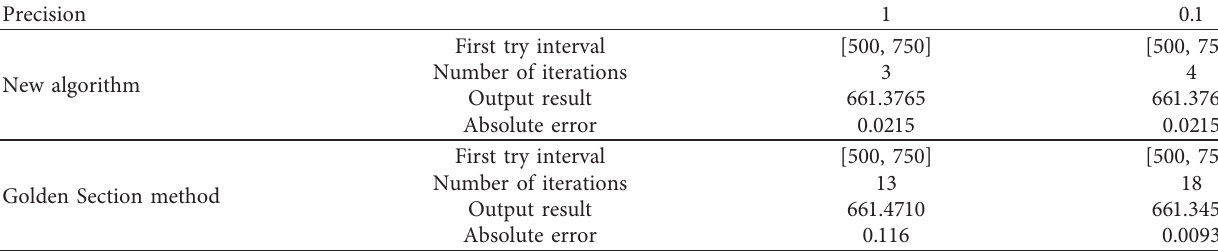
Table 2: Program running